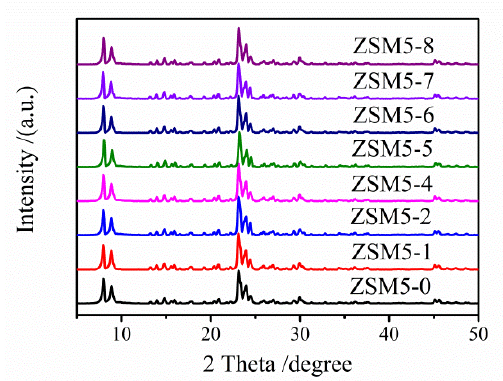
Figure 4. XRD patterns of ZSM-5 zeolite synthesized with different ethanol concentrations. Table 1. Textual properties of ZSM-5 zeolites prepared with different ethanol concentrations.